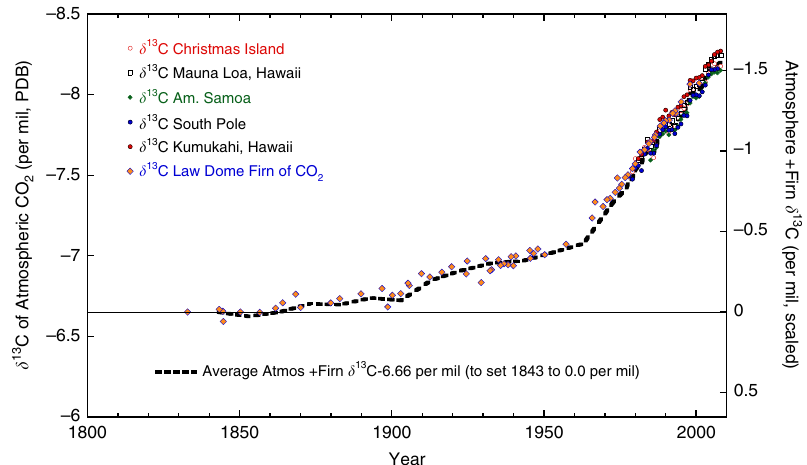
Fig. 1 The atmospheric 13 C Suess effect: atmospheric CO 2 δ 13 C results from stations at Christmas Island, Mauna Loa, Kumukahi, American Samoa, and the South Pole 41 compared to Antarctic fi rn CO 2 δ 13 C 2 . Black bold dashed line is our calculated average of these results that represents the 13 C Suess effect. We subtracted this average from our coral δ 13 C results from Fiji, Tonga, Rarotonga, and American Samoa to remove the 13 C Suess effect from these coral δ